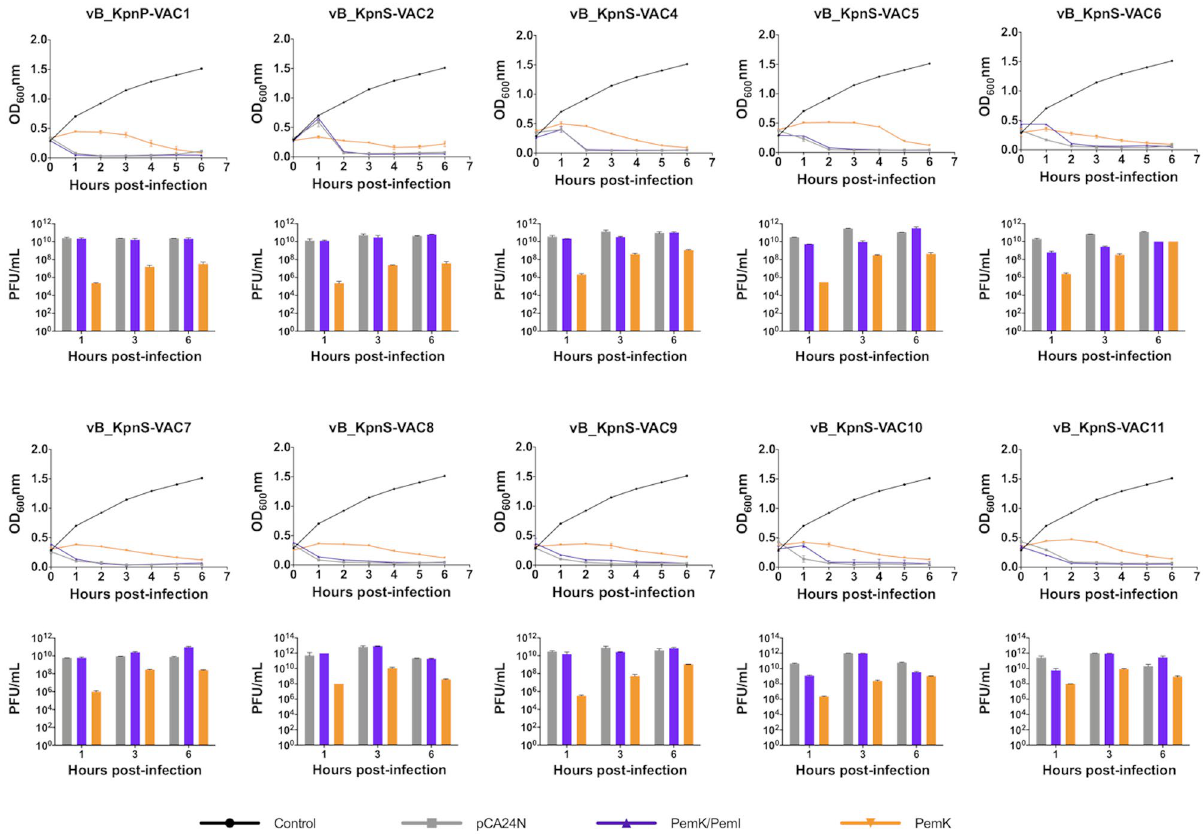
Figure 4. Infection curve for transformed strain ATCC10031/pCA24N, ATCC10031/pCA24N ( pemK/pemI ) and ATCC10031/pCA24N ( pemK ) in the presence of the ten lytic phages, and enumeration of PFU/mL after 1, 3 and 6 h of infection. The strain ATCC10031/pCA24N, harbouring the empty plasmid without phage infection was used as a control. In all cases there was a significant difference (p-value < 0.05) between the PFU/mL of the strain ATCC10031/pCA24N ( pemK ) and the strains ATCC10031/pCA24N and ATCC10031/pCA24N ( pemK/ pemI ). The errors bars represent the standard deviation of the three experimental